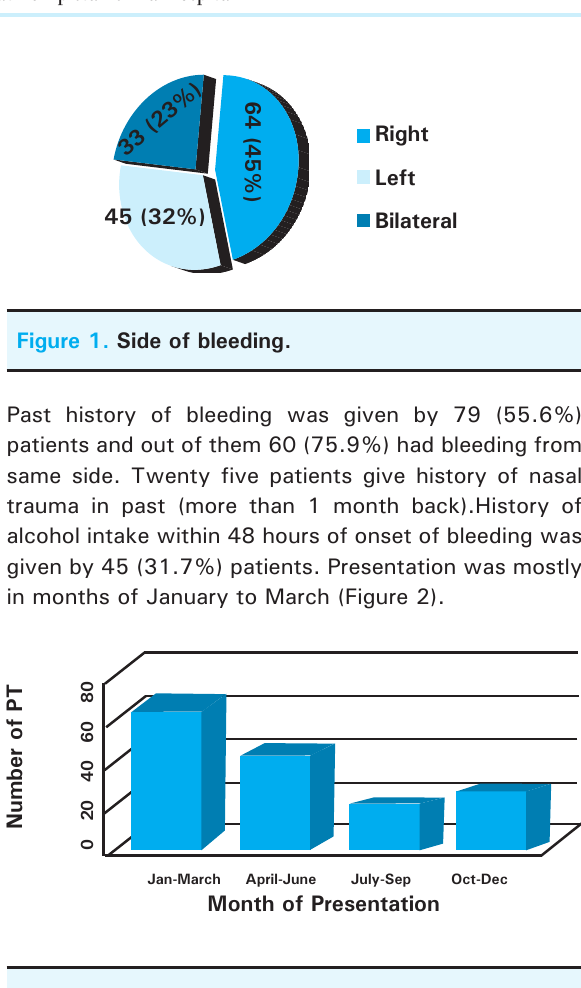
Figure 2. Frequency of patients in different months. Bleeding point was seen in 65 patients. Most of them (37/65) was in Little’s area and 12 patient had bleeding from spur and ten had bleeding from retrocolumnar vein. Four had bleeding from posterior septum while two had bleeding from lateral wall (Figure 3).